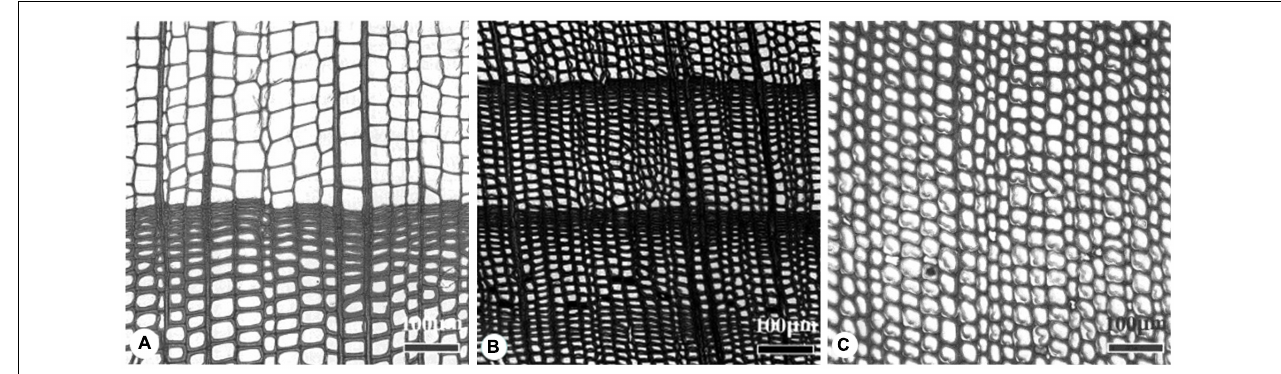
FIGURE 6 | Cross-sectional images of various xylem structures from three species in different families. (A) Abies holophylla (Pinaceae) inhabits a high latitude region and is adapted to freezing events; its xylem consists of highly contrasting tracheid sizes between earlywood and latewood; (B) Juniperus formosana (Cupressaceae) inhabits a middle latitude region and is more adapted to drought; its xylem consists of relatively small tracheid sizes with a noticeable contrast between earlywood and latewood due to a dry season; (C) Dacrydium pierrei (Podocarpaceae) does not possess a clear growth ring boundary or variable tracheid size, a consequence of its distribution in low latitude regions where it competes for light with many angiosperm trees in the tropical forest. Furthermore, these three species also have distinct differences in leaf shapes and pit membrane morphology, which allude to the different evolutionary directions of the three species. The scale bars are all 100 µ m in each image and the images were cited from Jiang et al. (2010) with